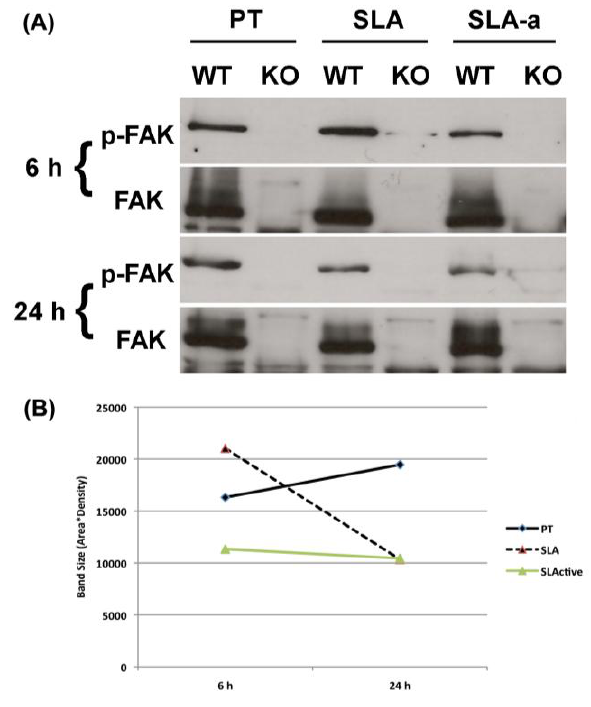
Figure 4. Influence of substratum topography and hydrophilicity on phosphorylated and total FAK in FAK −/− and WT fibroblasts cultured on PT, SLA and hydrophilic SLA at 6 and 24 h post seeding. ( A ) Representative Western blot image. Note the reduction in phosphorylated FAK in WT cells cultured on SLA and Hydrophilic SLA. ( B ), analysis of FAK band size/density using imageJ